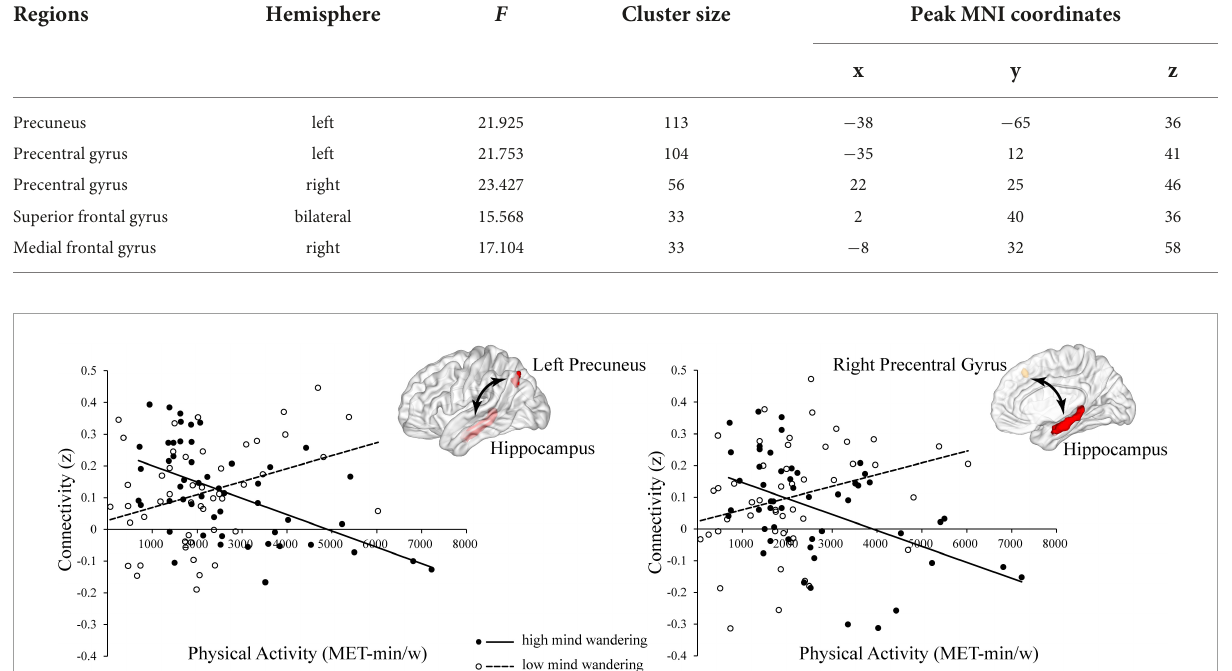
TABLE 2 Interactions between physical activity and mind wandering.